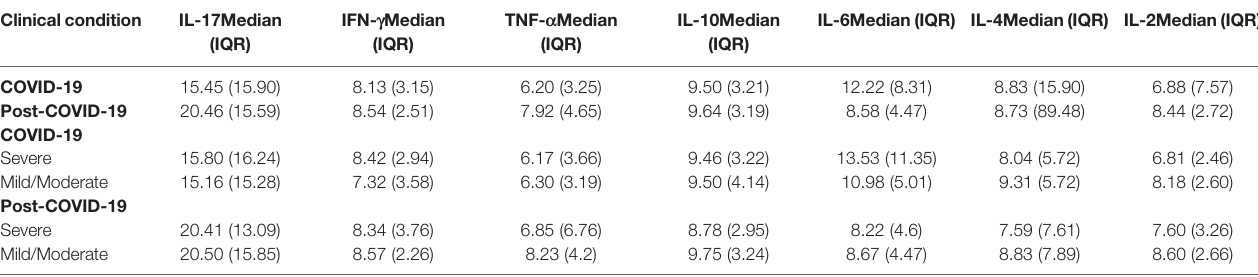
TABLE 1 | - Median cytokine levels evaluated among patients with different clinical COVID-19 and post-COVID-19 conditions.